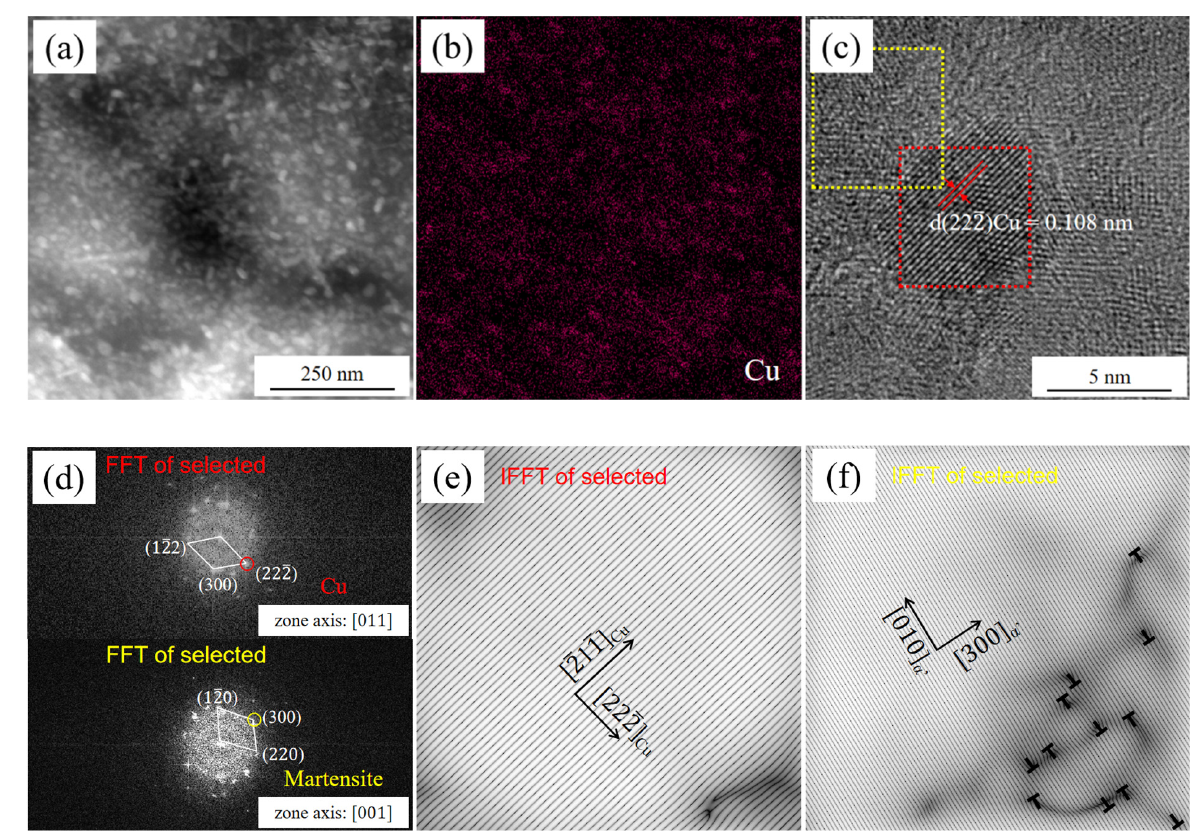
Figure 8. ( a ) TEM morphology of rich-Cu precipitates. ( b ) EDS element map corresponding to ( a ). ( c ) HRTEM image of spherical rich-Cu precipitates. ( d ) FFT patterns of selected regions in ( c ). ( e , f ) IFFT patterns of selected g 222Cu and g 300 α ’ spots.